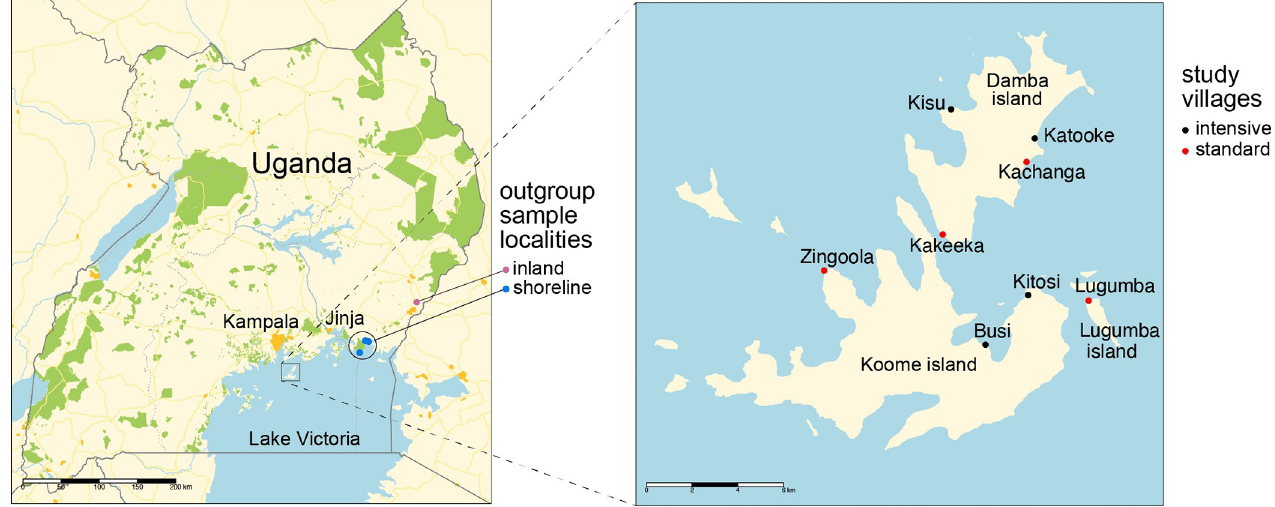
Fig 1. Location of sample sites within Uganda. Villages with black dots received standard (annual) intervention, those with red dots received intensive (quarterly) intervention. Outgroup samples were obtained from locations marked as inland and shoreline. Map data is from https://data.humdata.org/dataset/